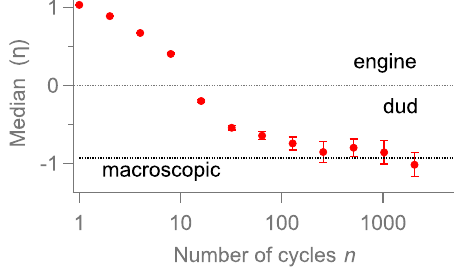
FIG. 6. Median of the efficiency distribution as a function of the